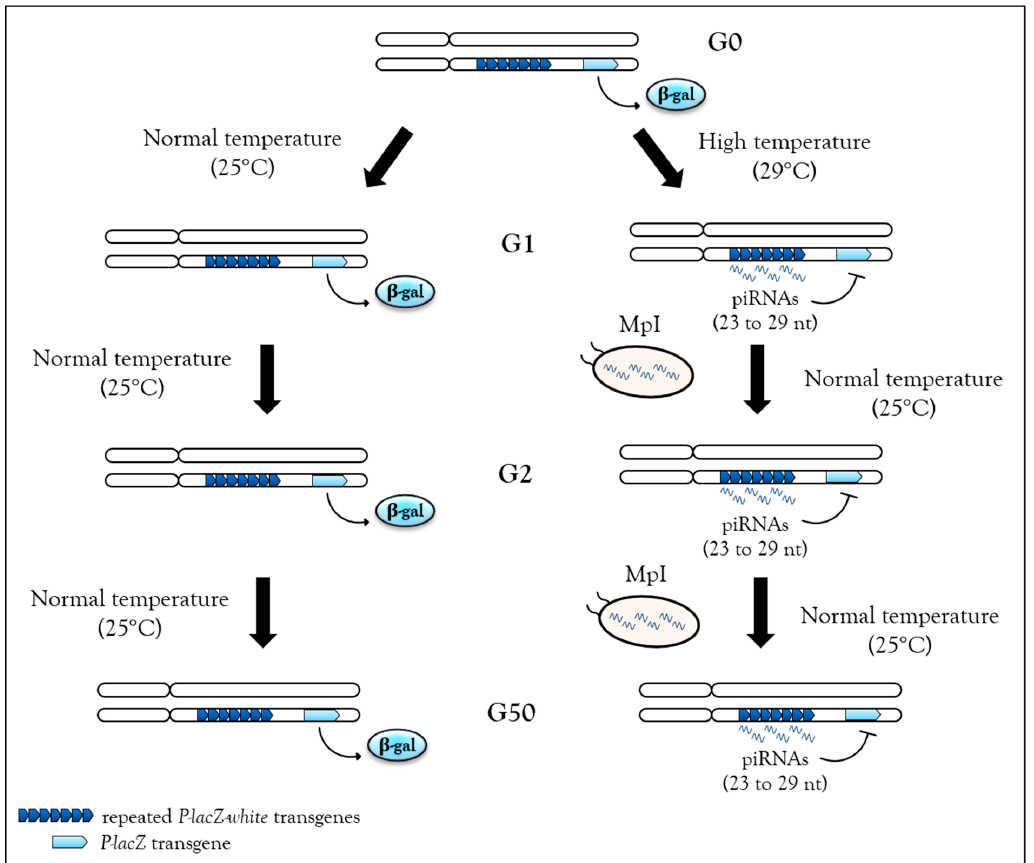
Figure 3. Stable, heritable stress-induced de novo piRNAs. In flies, the BX2 cluster, a sequence made of repeated P-lacZ-white transgenes (dark blue arrowheads), is capable of producing piRNA after one generation at 29 °C, then these piRNAs can functionally repress a homologous P-lacZ sequence (light blue arrowheads) in trans . This silencing capacity is maintained at the second generation after return to normal temperature (25 °C) and then up to 50 generations. Hence, when stress is removed, piRNAs can be self-maintained by maternal piRNA inheritance (MpI) at each generation.